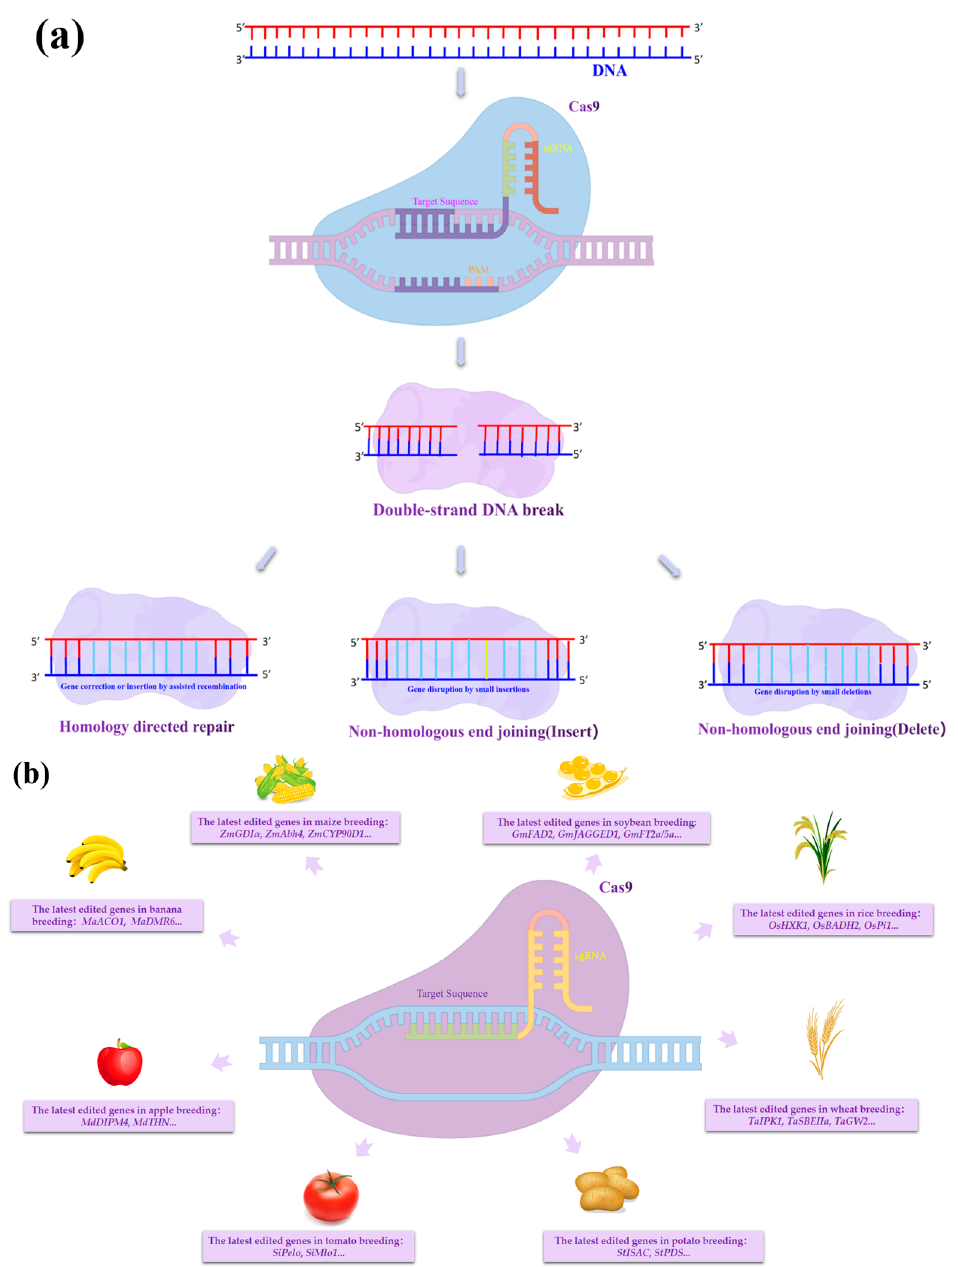
Figure 1. Principle of CRISPR/Cas9 gene-editing technology and targeting genome: ( a ) Mechanism of CRISPR/Cas9-mediated DNA repair; ( b ) CRISPR/Cas9 targets different plant genomes. CRISPR/Cas9 targeting of the target genome first produces a double-stranded DNA break, followed by two DNA repair mechanisms, non-homologous end-joining, and homologous recombination, in which editing occurs during the repair process. Non-homologous end-joining often produces deletions and insertions of target sequences, and homologous recombination produces exchanges of target sequence fragments or base substitutions. The figure mentions the names of the genes recently targeted by CRISPR/Cas9 in different major crops.